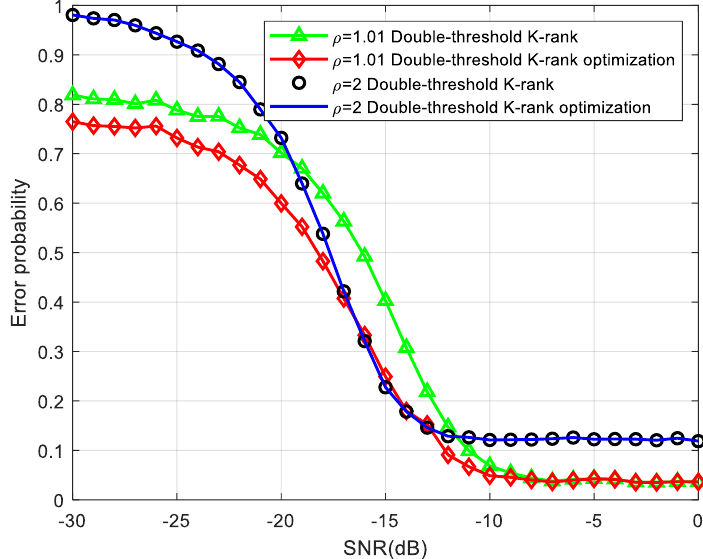
Figure 5. Performance of optimized K-rank algorithm.